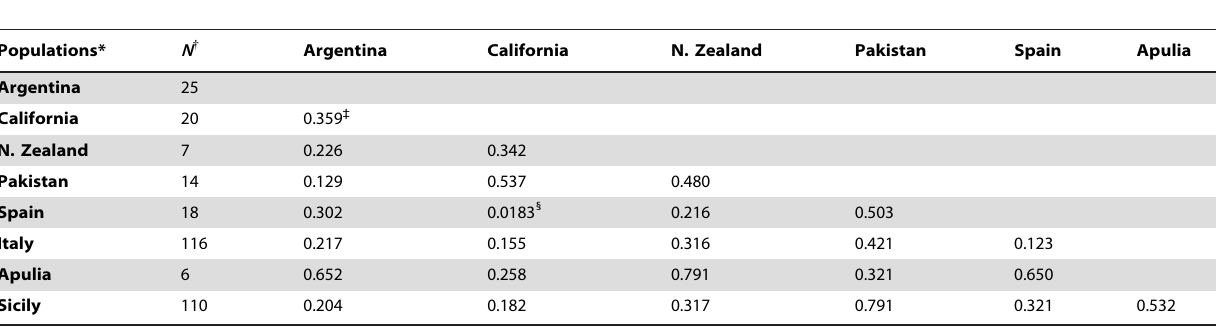
Table 4. F st values and Ks* , Z* and S nn tests between pairs o CTV populations for the p20 gene.